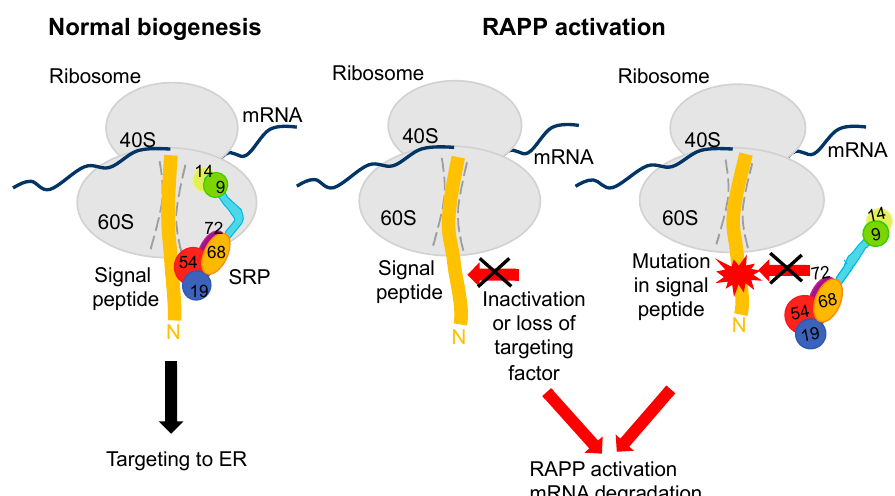
Figure 3. Regulation of Aberrant Protein Production (RAPP) pathway. During normal biogenesis, SRP functions co-translationally as a targeting factor for delivery of secretory proteins into ER. If interactions between signal peptide of the secretory proteins and SRP are disrupted due to inactivation of SRP, loss of targeting factor or mutations in a signal peptide, then RAPP is activated and mRNA of the secretory proteins is degraded [8,23,24]. SRP subunits are labeled by numbers and colors as in Figure 1.